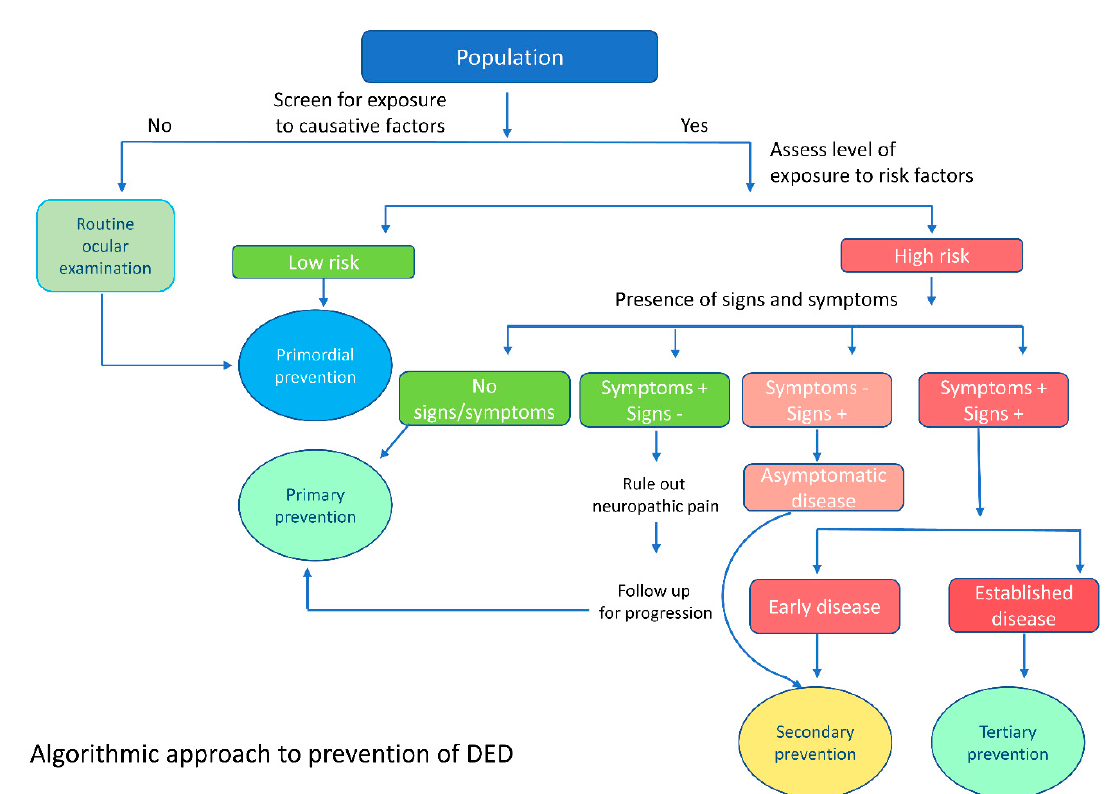
Figure 2. Algorithm for the prevention of dry eye disease: the figure depicts the approach to evaluating a patient with dry eye disease and the institution of various preventive strategies based on the clinical course and disease severity. The low-risk and high-risk stratification is based on the strength of the evidence present in the literature with regards to the association of a risk factor with DED, as stated in the Tear film and ocular surface society – dry eye workshop II (TFOS DEWS II) epidemiology report [2]. High risk includes risk factors such as age, female gender, connective tissue disorders, Sjogrens syndrome, VDU use, contact lens use, Bone marrow transplantation, and environmental factors. Low risk factors include post refractive surgery, allergic conjunctivitis, thyroid disease, psychiatric conditions, diabetes, and low fatty acid intake.